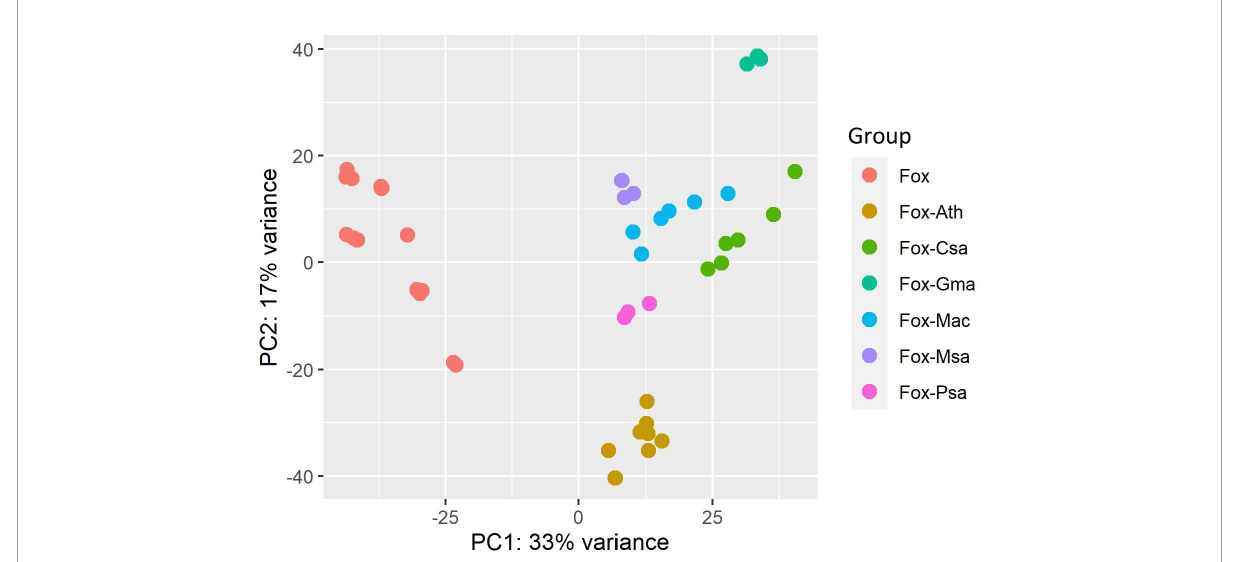
FIGURE1 Principal component analysis (PCA) of the heterogeneous RNA-seq datasets characteristics. Fox, Fox-Ath, Fox-Csa, Fox-Gma, Fox-Mac, Fox-Msa, and Fox-Psa represent F. oxysporum transcriptome-wide expression profiles for an in vitro culture, and F. oxysporum infection of Arabidopsis thaliana , Cucumis sativus , Glycine max , Musa acuminata , Medicago sativa , and Pisum sativum , respectively.